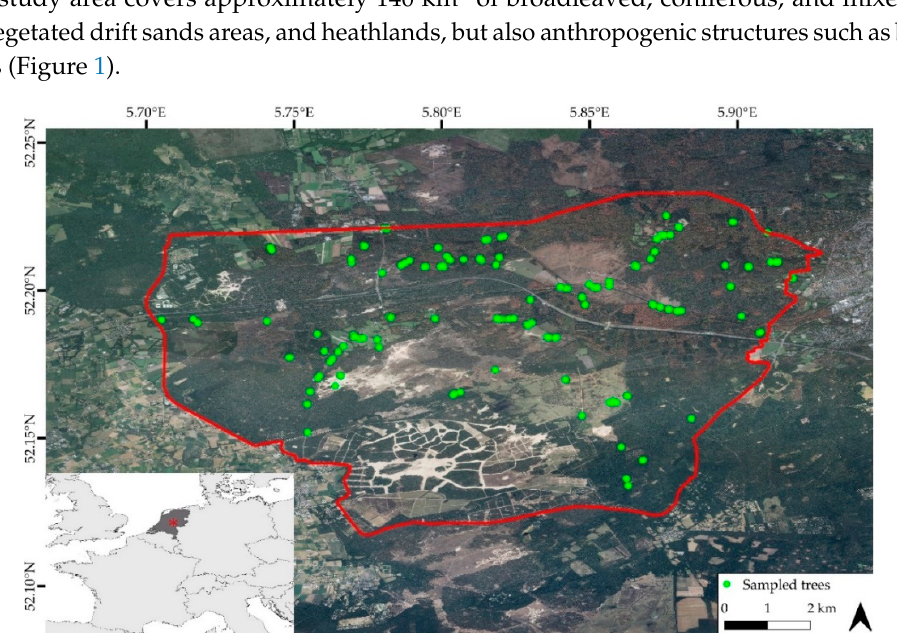
Figure 1. Location of the study area (inside the red line) in the Netherlands. The green dots show the location of the sampled trees and are plotted over airborne imagery from 2018, acquired from Publieke Dienstverlening Op de Kaart (PDOK).